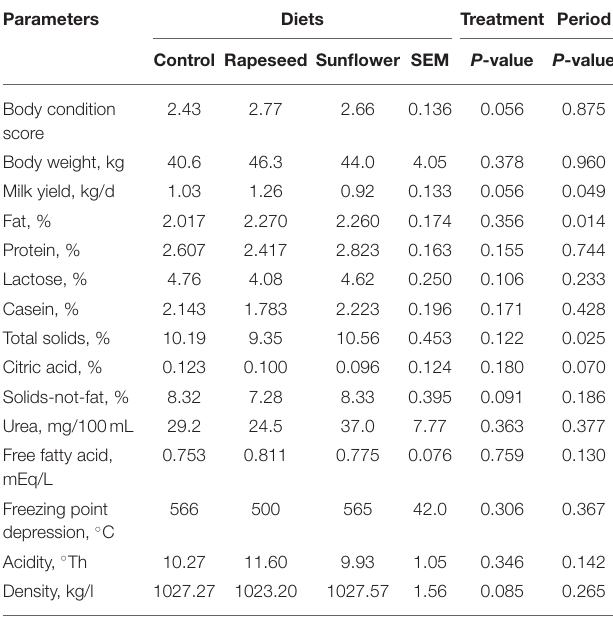
TABLE 2 | Performance and milk composition from goats supplemented with rapeseed oil and sunflower oil (4% DM). Parameters Diets Treatment